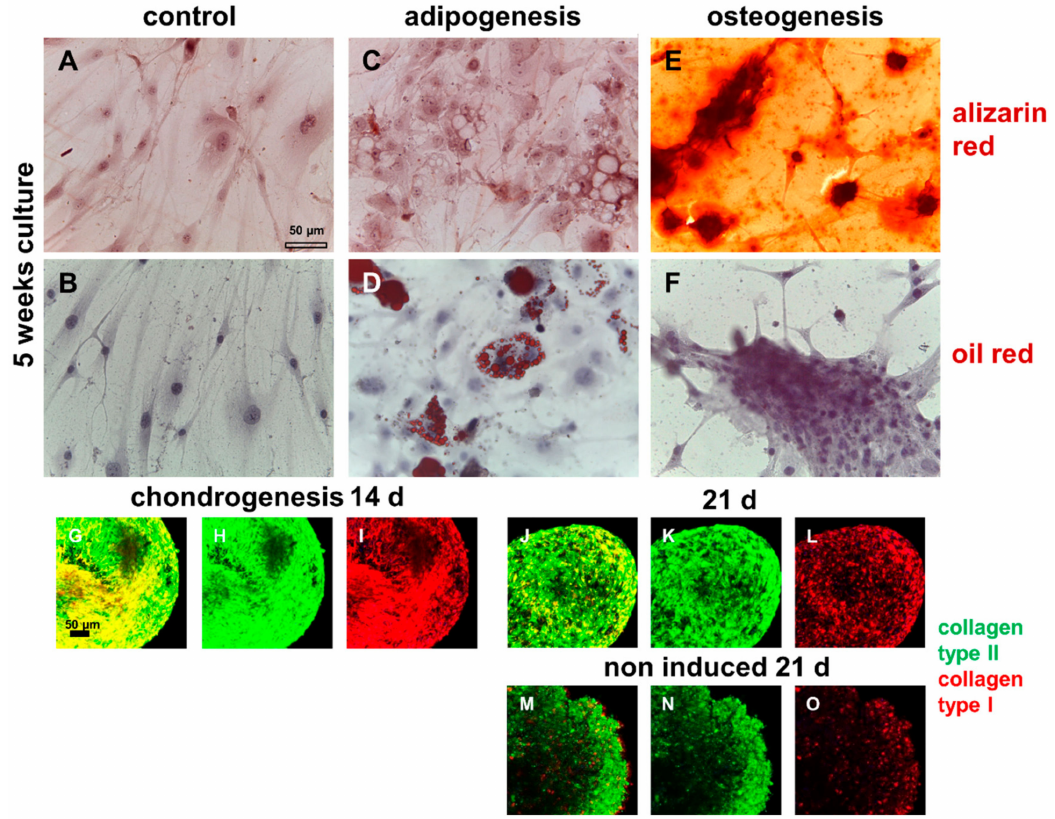
Figure 8. The multilineage di ff erentiation potential of isolated migrative ITB cells. ( A , C , E ) Alizarin red staining. ( B , D , F ) Oil red staining. A , B : Non-induced control. C , D : Adipogenically induced. E , F : Osteogenically induced. Chondrogenically induced for 14 d ( G – I ) or 21 d ( J – L ) and noninduced for 21 d ( M – O ). G , J , M : Merged (collagen type I: red, collagen type II: green); H , K , N : collagen type II (green); I , L , O : collagen type I (red). Scale bars: 50 µ m. ITB, iliotibial